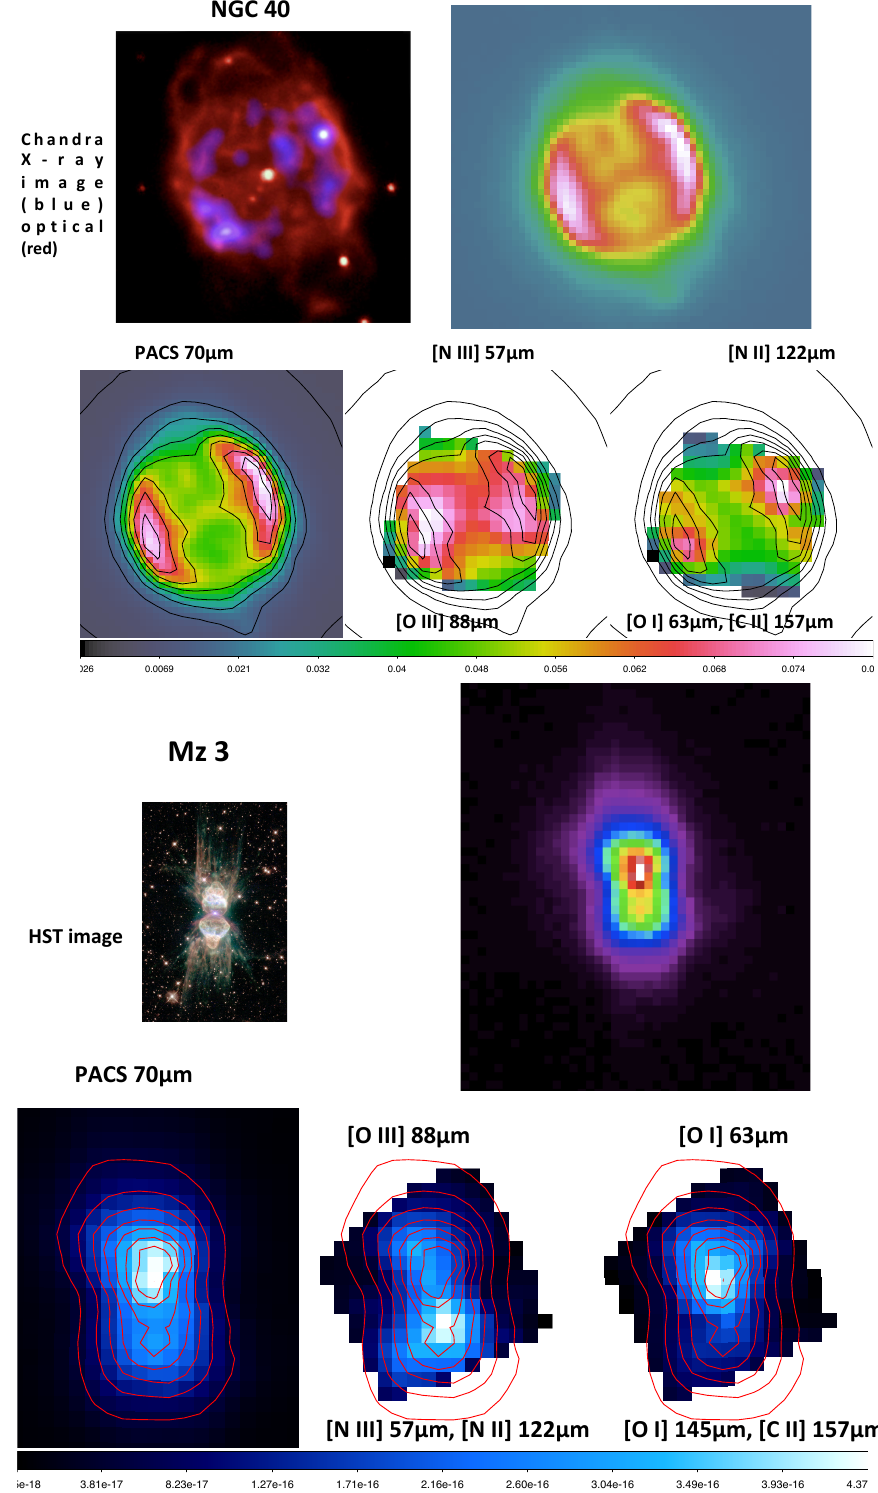
Figure 2. ( Top ) NGC 40, with an X-ray/optical image composite and the PACS 70 µ m image, and the IR image with the two spectral images on the bottom. ( Bottom ) Mz3, optical image (HST, WFPC2) and the PACS 70 µ m image at the top, and the IR image with the two spectral images on the